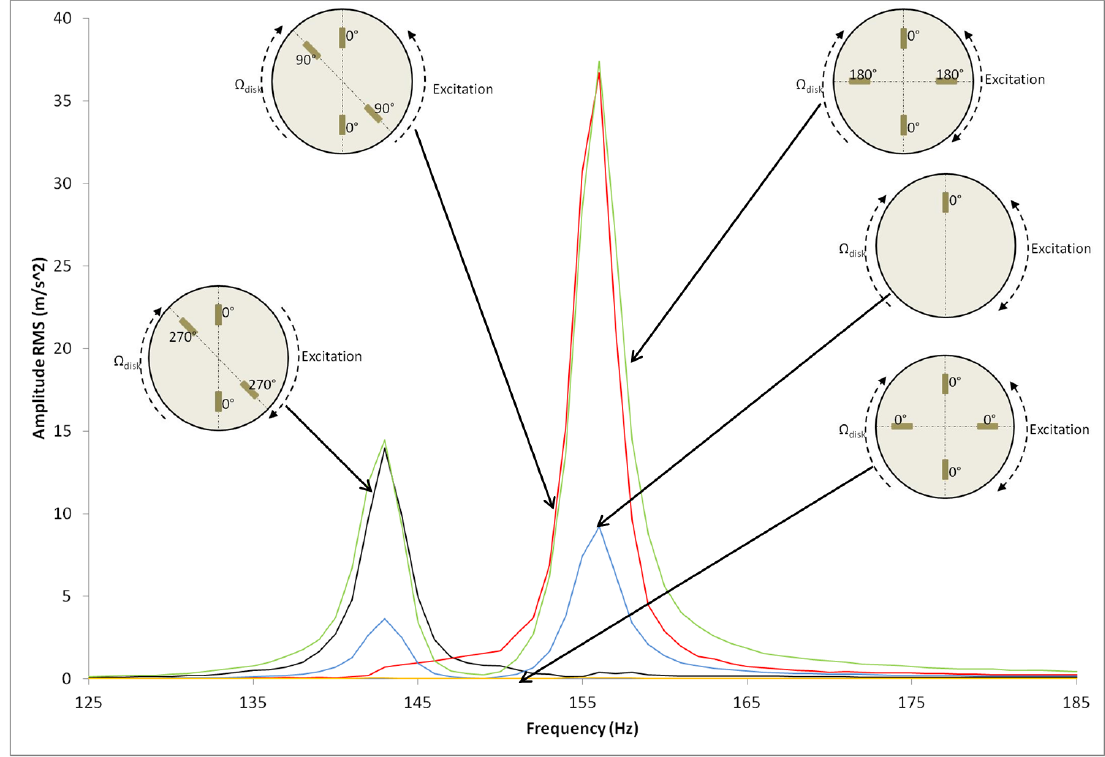
Figure 12. Resonances around n = 2 and n = −2 (experimental) for the disk rotating in water ( = 8 Hz). Different excitation disk